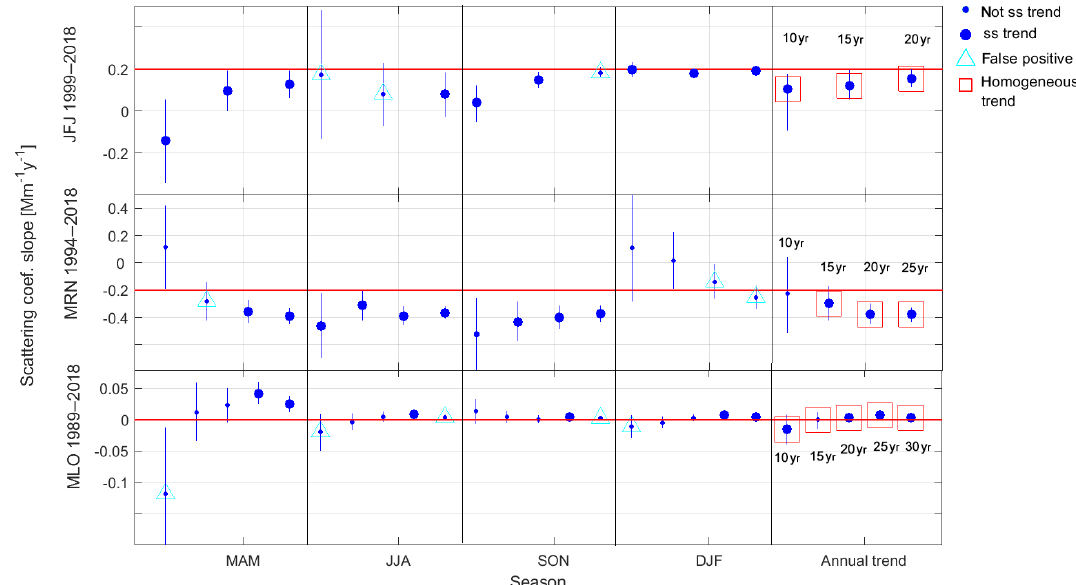
Figure 2. Seasonal MK results for the σ sp trend for three stations with long time series: JFJ, MRN and MLO. The trends are plotted for the last 10-year period (2009–2018) as well as for all possible longer periods (15 years = 2004–2018 to 30 years = 1989–2018). The seasons correspond to meteorological seasons (MAM: March–April–May, JJA: June–July–August, SON: September–October–November and DJF: December–January–February). The dots correspond to the slope, large dots being ss at the 95% confidence level, whereas small dots are not ss trends. The cyan triangles correspond to false positive trends (with type 1 error). Red squares correspond to annual trends where the seasonal results are